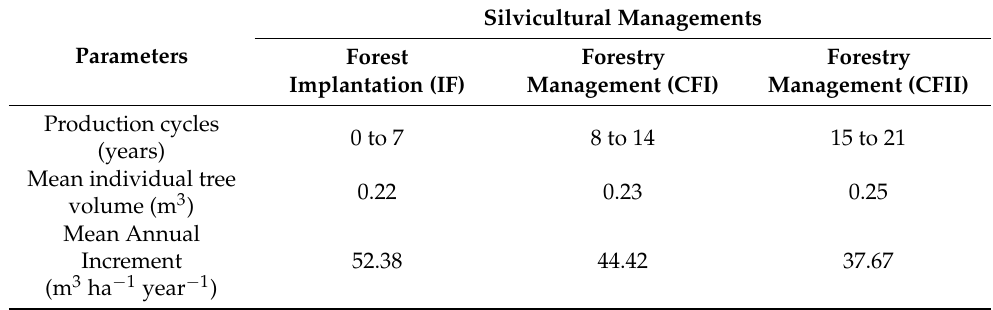
Table 1. Technical parameters of silvicultural